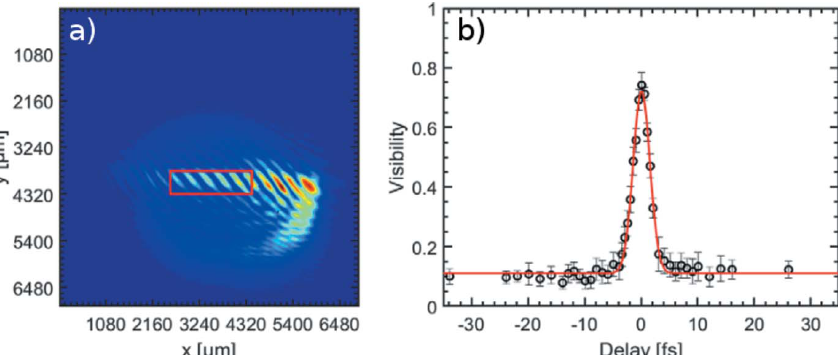
Figure 12 ( a ) Interference pattern taken at (cid:4) = 8 nm and (cid:2) t = 0 fs. The visibility in the region marked by the red rectangle amounts to V = 0.8. ( b ) Temporal visibility distribution of the FEL beam at (cid:4) = 8 nm. Every point represents the average of 25 individual interference patterns taken at one delay. The